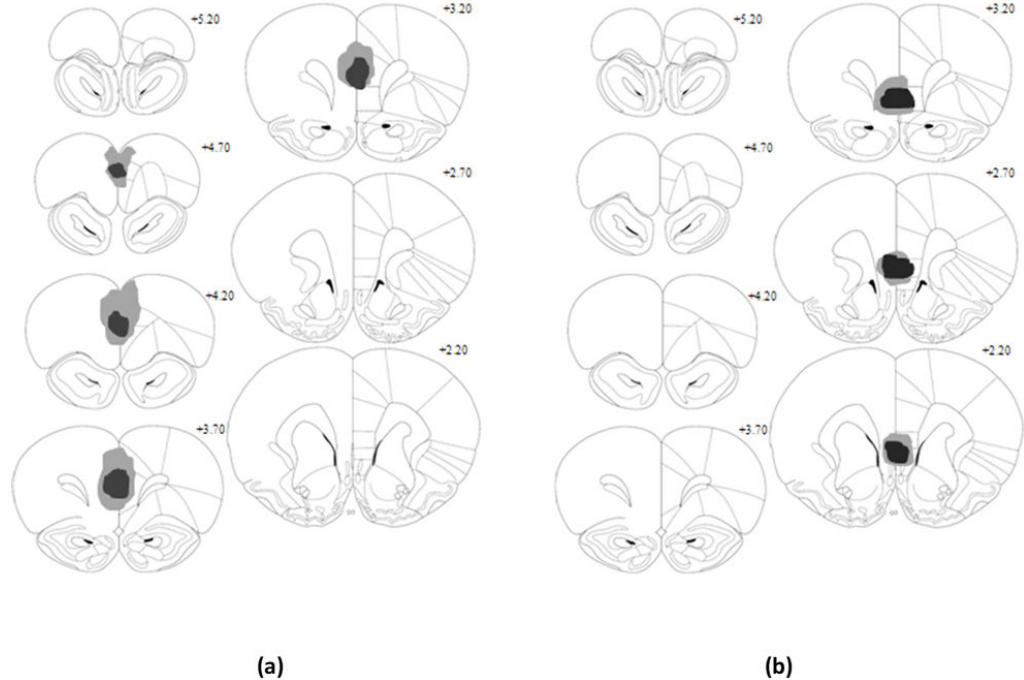
Figure 1. Schematic representation of location and extent of excitotoxic lesion damage to the prelimbic (PL; a ) and infralimbic (IL; b ) cortices. Shaded regions indicate the minimum (black) and maximum (grey) area covered by the lesions. Coronal sections displayed here are +2.20 to +5.20 (in mm from